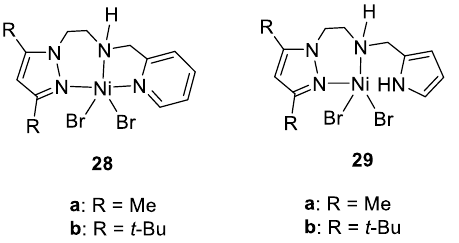
Figure 17. Pyrazolylpyridinamine and pyrazolylpyrroleamine nickel complexes.